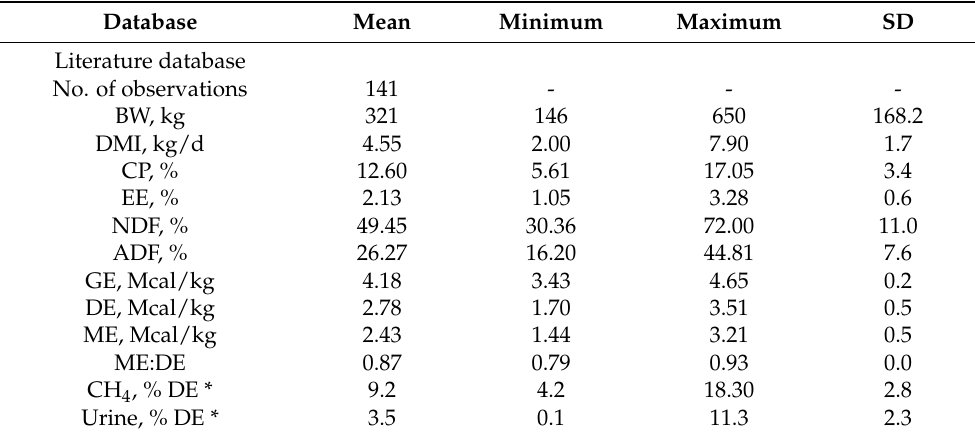
Table 2. Variability of the chemical components of the diets (DM basis), DM intake and animal BW in the